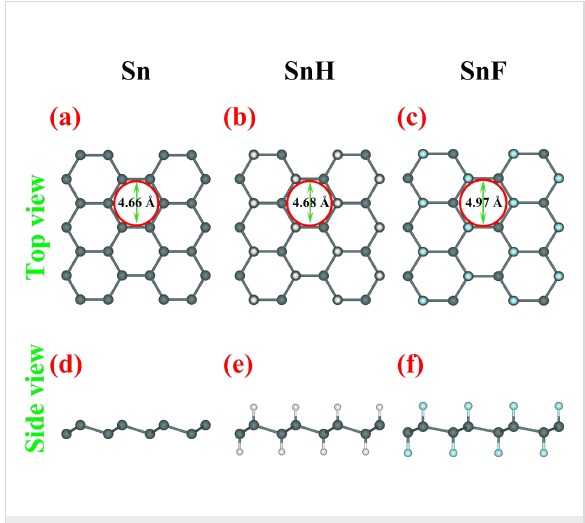
Figure 1: The geometrical structures of Sn, SnH, and SnF lattices from top (a–c) and side (d–f) views. Color code: grey, Sn; white, H; light green,